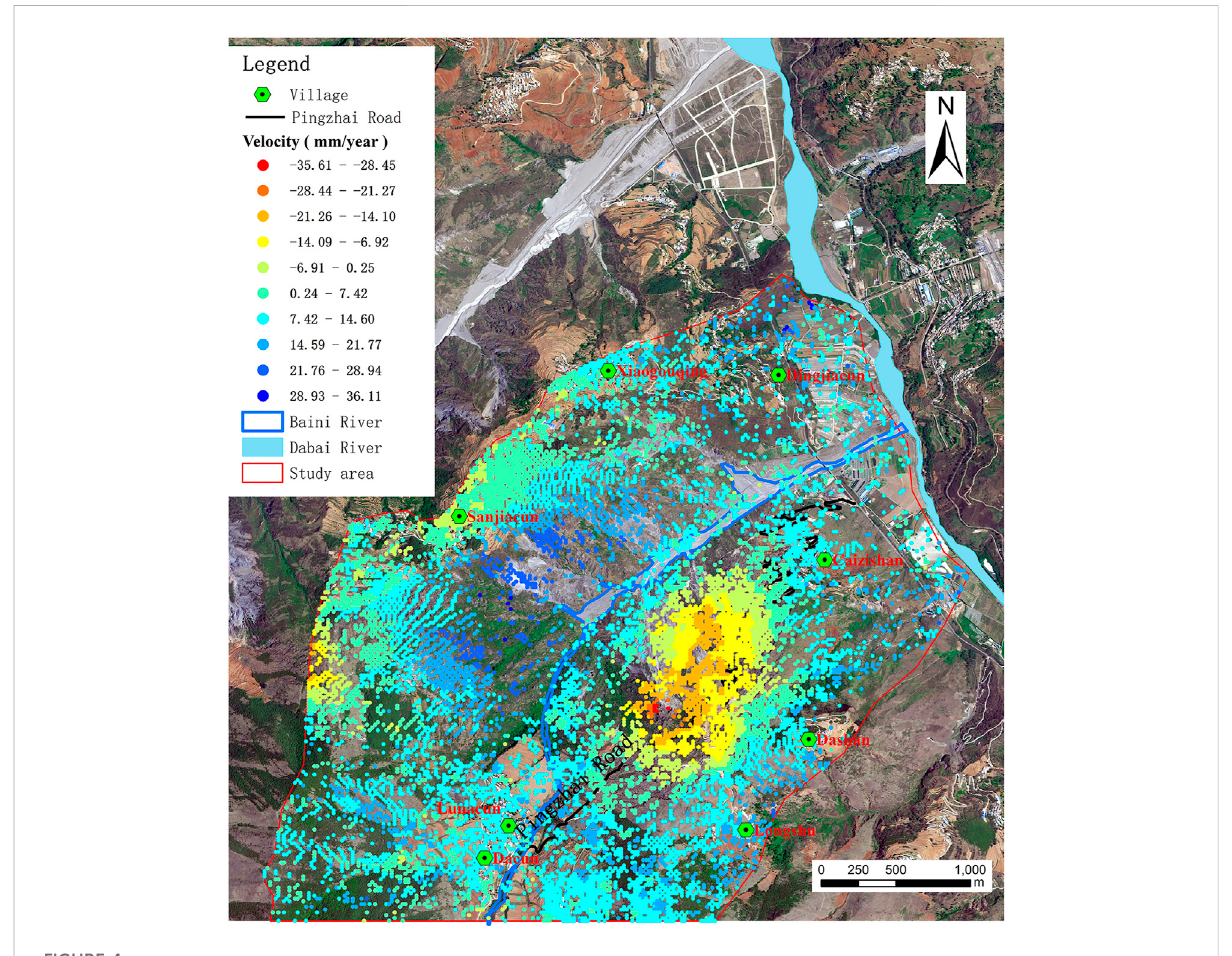
FIGURE 4 Annual average deformation rate of the study